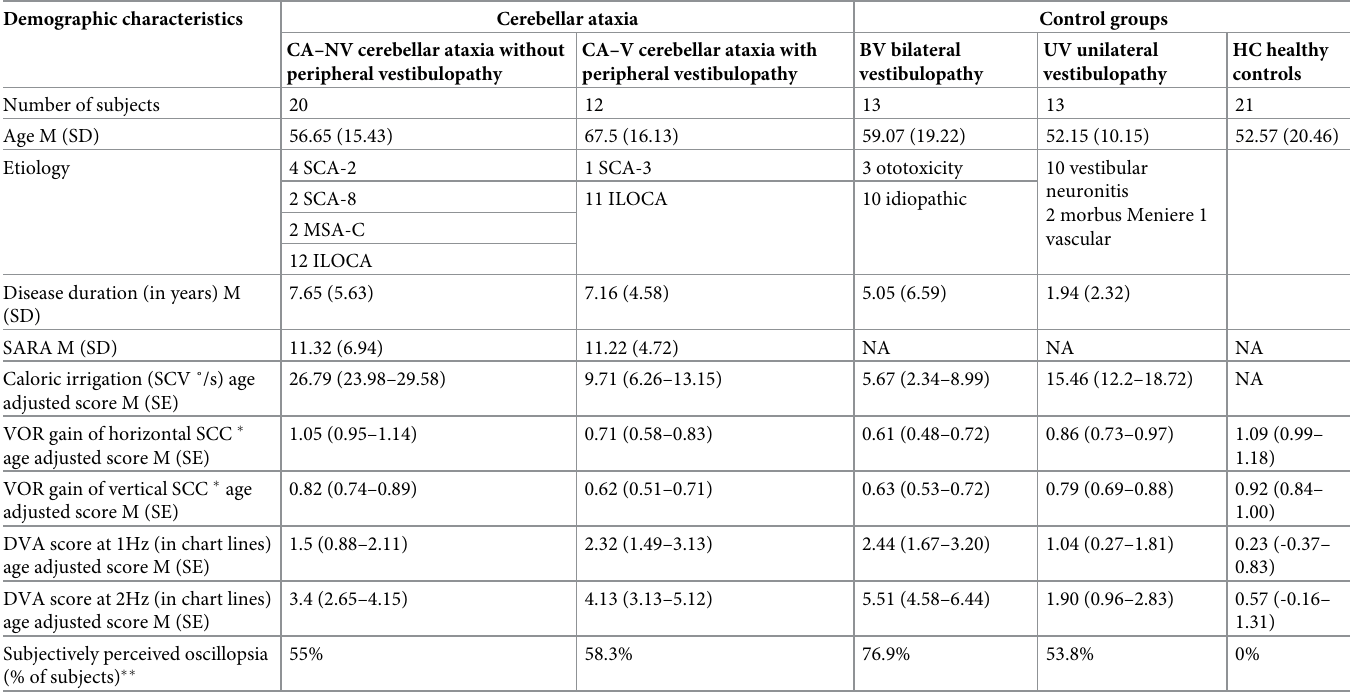
Table 1. Demographic, clinical characteristics and